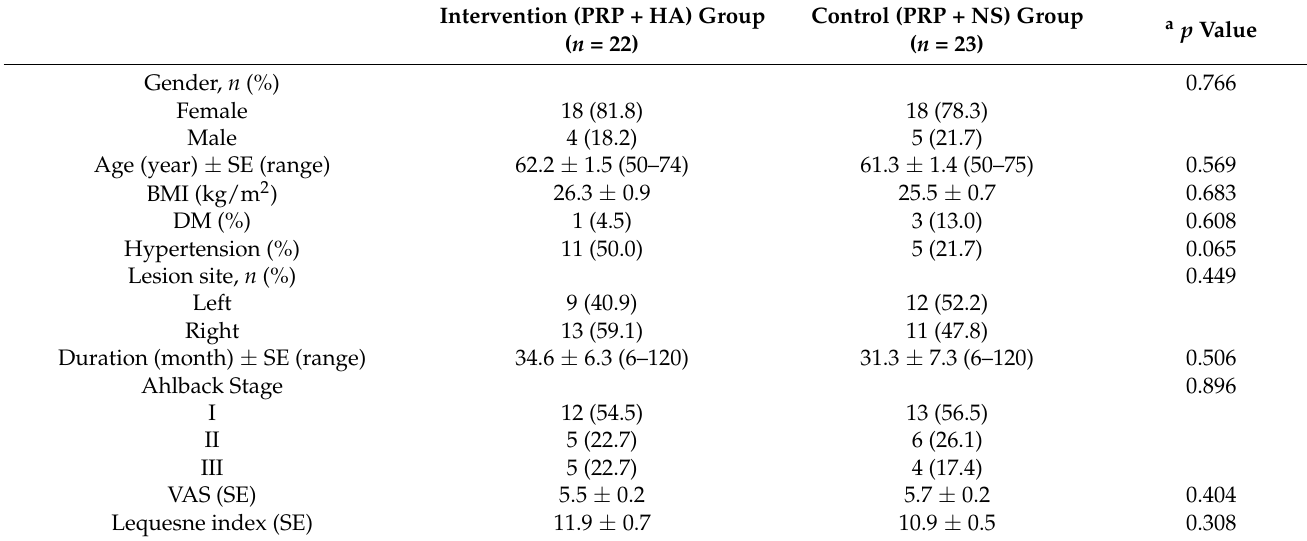
Table 1. Baseline demographic and clinical characteristics of study subjects.